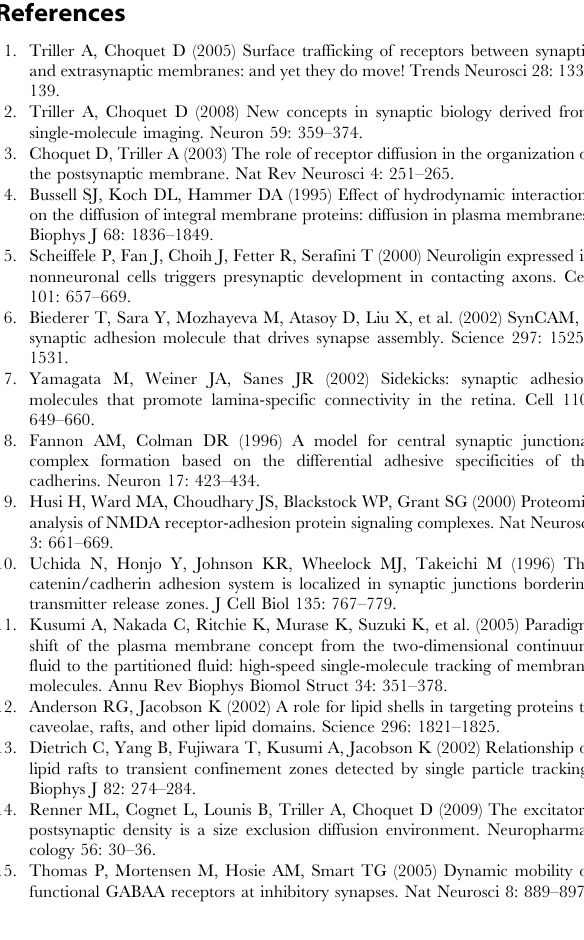
Figure S1 SEP-GABA A R c 2 clusters are localized at the neuronal cell surface. (A) Live cell imaging of recombinant SEP-GABA A R c 2 (green) and mRFP-Gephyrin (red) in hippo- campal neurons transfected at DIV10. Scale bar, 1 m m. When live